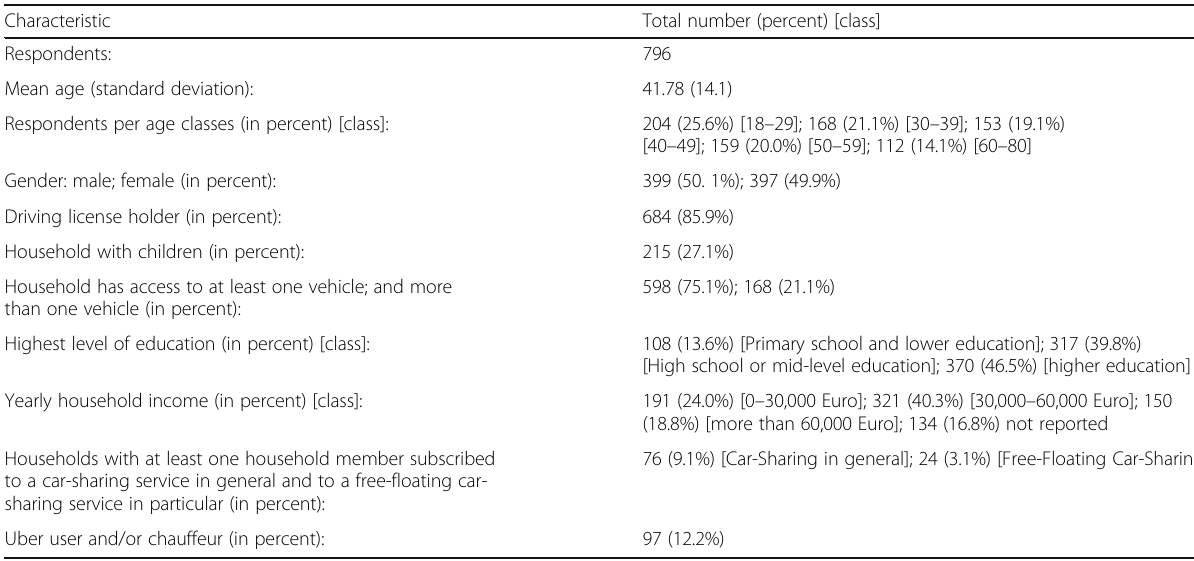
Table 2 Main socio-demographic characteristics of respondents